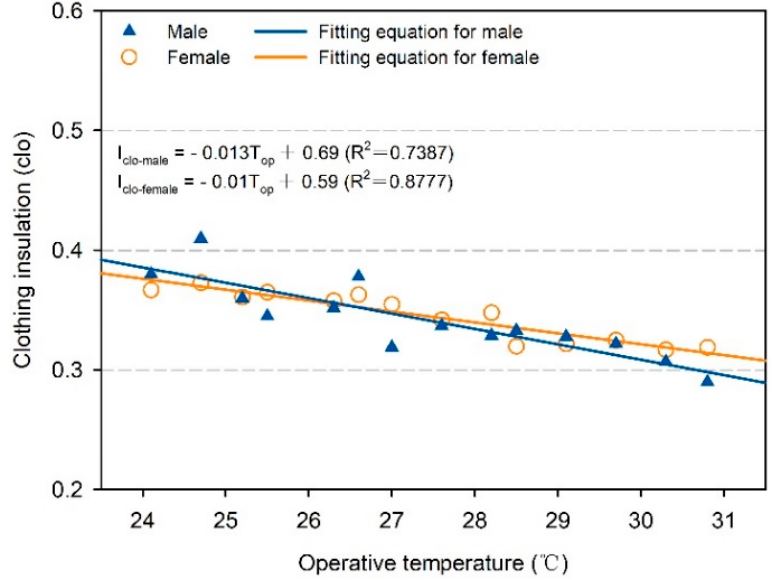
Figure 11. The relationship between operative temperature and clothing insulation.